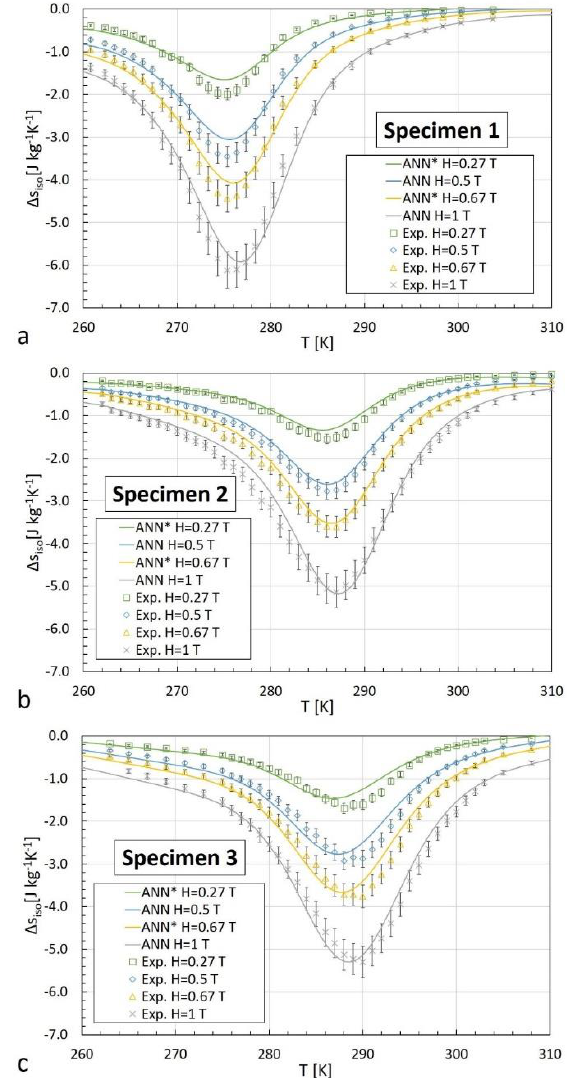
Figure 8. Comparison between the isothermal entropy changes of the three samples of La-Fe-Co-Si alloy at different magnetic fields calculated with the ANN approach and those calculated by numerical integration. The asterisk in the legend indicates an applied magnetic field not included in the training dataset.